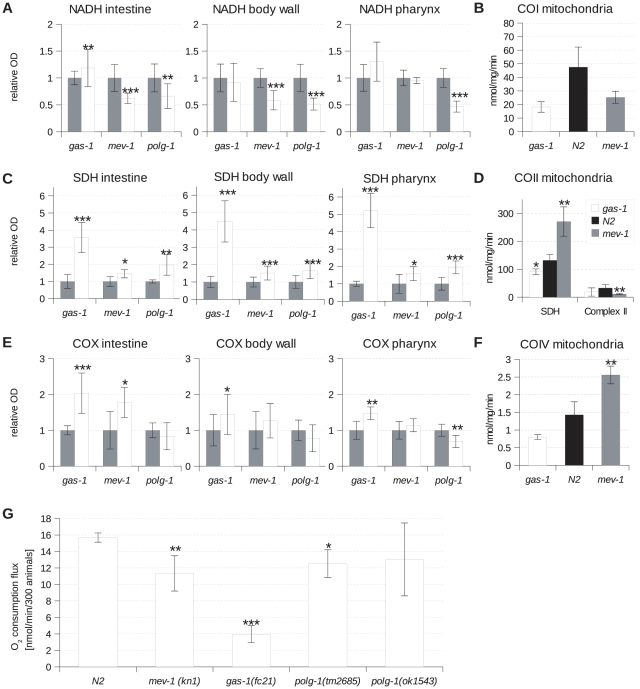
Analysis of mitochondrial function in C. elegans by histochemistry in gas-1(fc21), mev-1(kn1) and polg-1(ok1548) animals.NADH (A), SDH (C) and COX (E) activity in intestine, body wall, and pharynx tissue. Gray bars refer to wild type animals (N2) and white bars to corresponding mutant animals indicated on the chart. (B) Complex I, (D) Complex II and SDH, (F) Complex IV activity measured on isolated mitochondria by spectrophotometry. (G) Oxygen consumption flux of young adults at day 1 of adulthood. Bars represent standard deviation of the mean. Asterisks denote statistical significance in comparison to wild type (Student's t-test, * p<0.05, ** p<0.01, *** p<0.001).